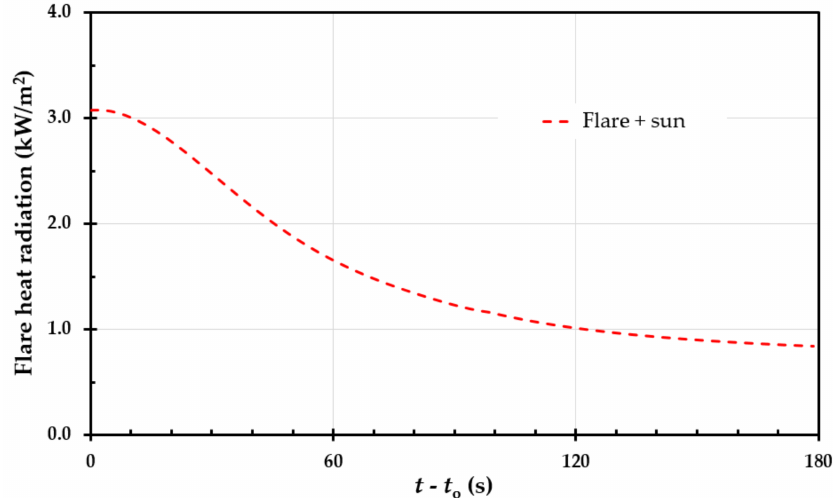
Figure 5. The total (flare + 700 W/m 2 solar radiation) heat flux as a function of time to a passerby evacuating from the most exposed area at a speed of 2 m/s (based on data for Case 1, Table 2).